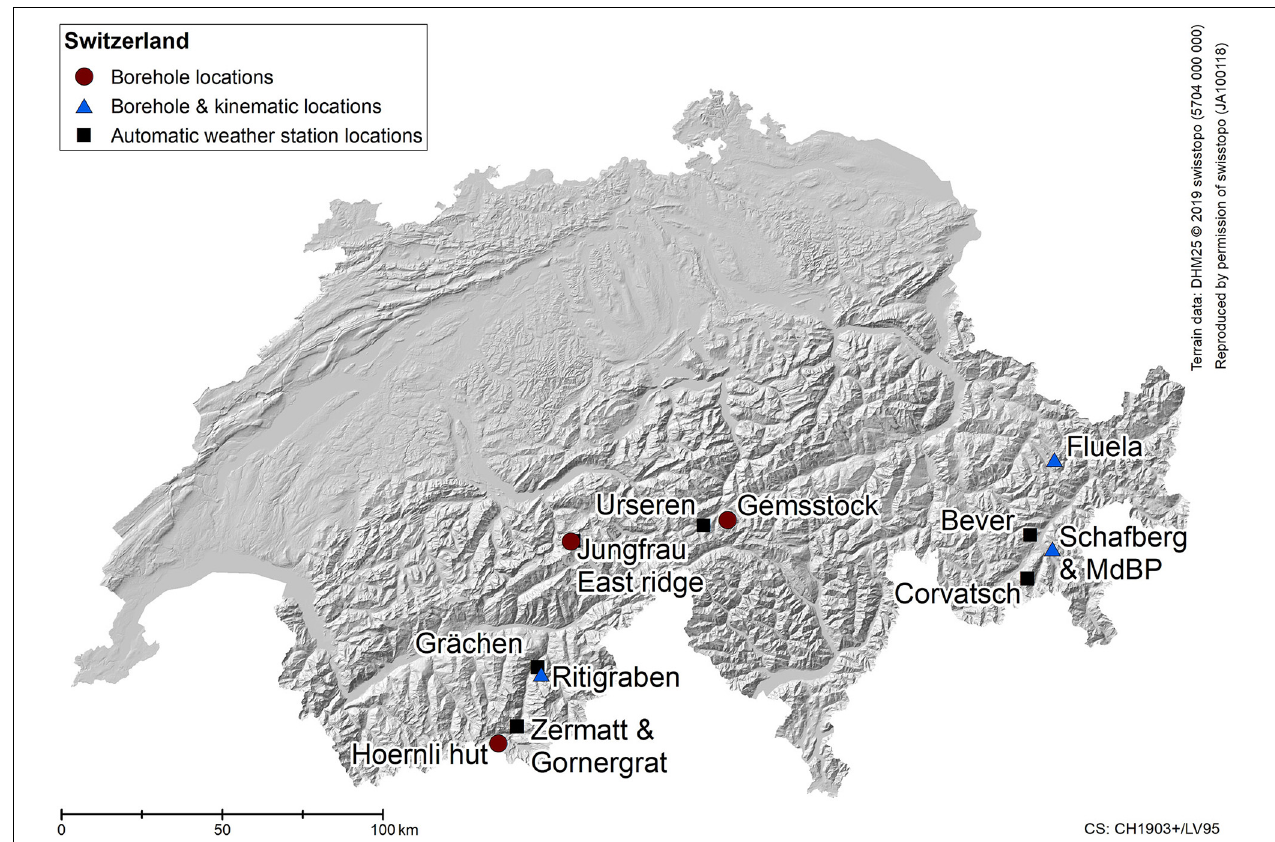
FIGURE 1 | Overview of the borehole and kinematic sites presented here ( Table 1 ) as well as the automatic weather stations used. Temperature and kinematic monitoring sites (blue triangles) include: ground temperature data, TLS, and GNSS observations. At borehole locations (red dots) only borehole temperature measurements exist. The Schafberg & MdBP site includes the boreholes Schafberg B1 and B2 as well as Muot da Barba Peider B1 (MdBP). The Jungfrau East ridge site includes the borehole as well as the automatic weather station at